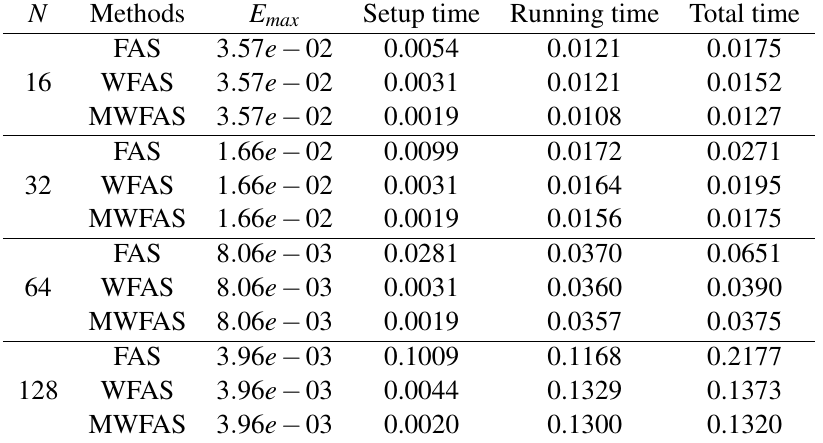
Table 6 Maximum error and CPU time (in seconds) of the methods of test problem